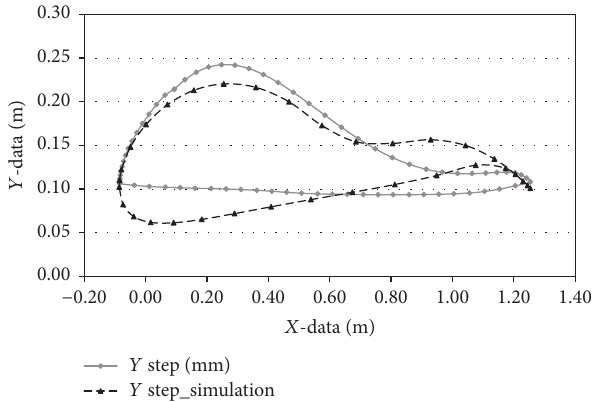
Figure 9: Comparison between measured and simulated trajectory in transverse plane during gait cycle.